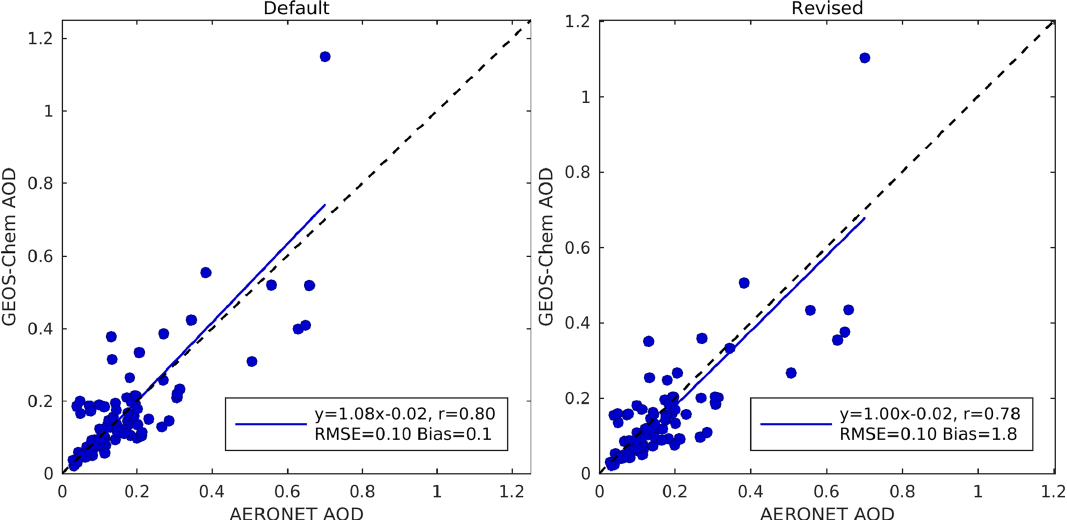
Figure B3. Coincident simulated vs. measured AOD at 550nm at AERONET sites for the year 2006, using default and revised sizes and hygroscopicity. Slope, offset, and correlation coefficient are inset. The 1 : 1 line is shown in black.